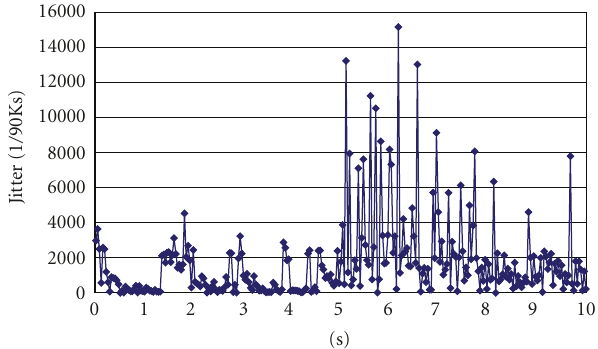
Figure 1: Abnormal jitter detection at a receiver.